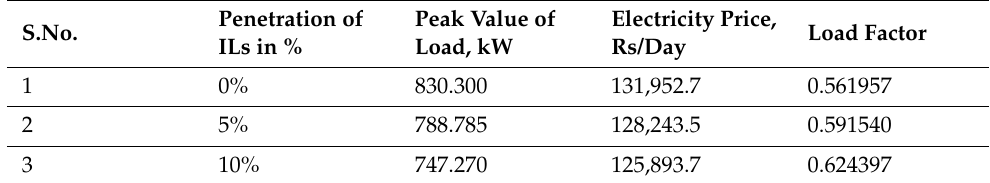
Figure 20. Electricity price of consumers for three cases considered. Table 10. Comparison of peak demands, electricity price, and load factor with penetration of